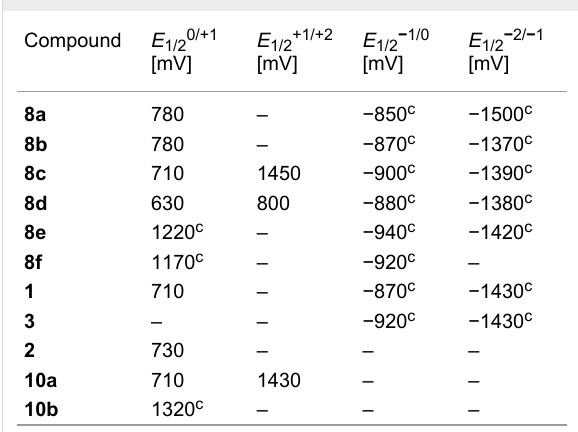
Table 1: Cyclovoltammetric data of the dyads 8 and the reference systems 1 , 2 , 3 and 10 (recorded in CH 2 Cl 2 , T = 298 K, c = 0.1 mol·L − 1 , Pt working electrode, Pt counter electrode, Ag/AgCl reference electrode, electrolyte N( n- Bu) 4 PF 6 , scan rates v of 100, 250, 500 and 1000 mV·s − 1 ) a,b .